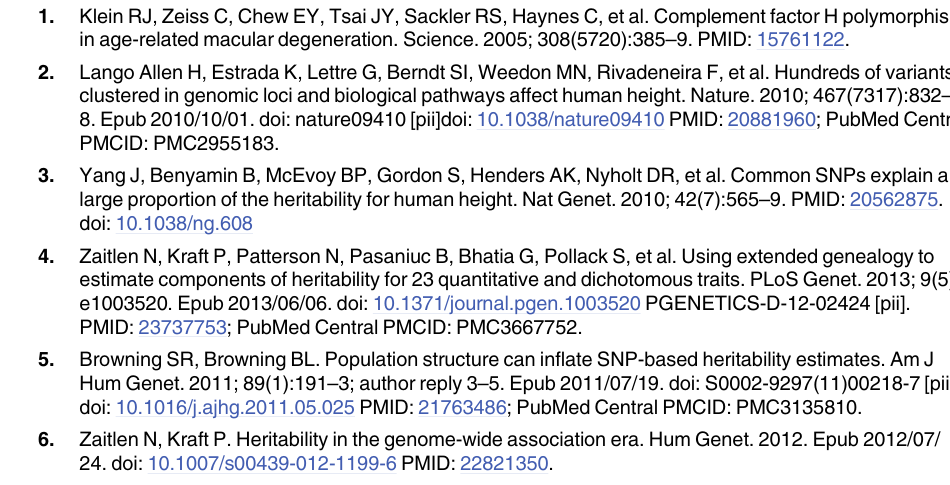
S1 Table. Tabulations of the score test T 2 . Empirical critical value under null hypothesis, and type I error given critical value 3.84 over 3000 simulations for varying number of SNPs (M), numbers of observations (N) and relatedness matrix K